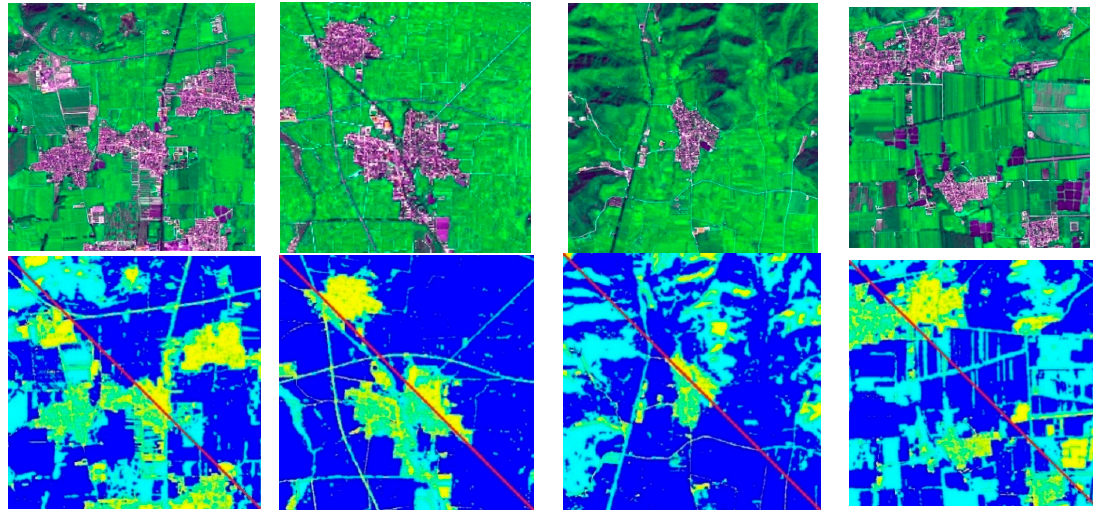
Figure 4. Clustering in CIELab ( upper triangle ) and RGB ( lower triangle ).